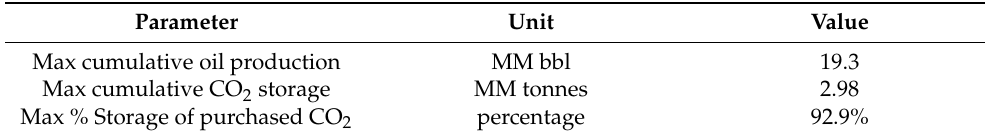
Table 2. Summary of predicted volumes.